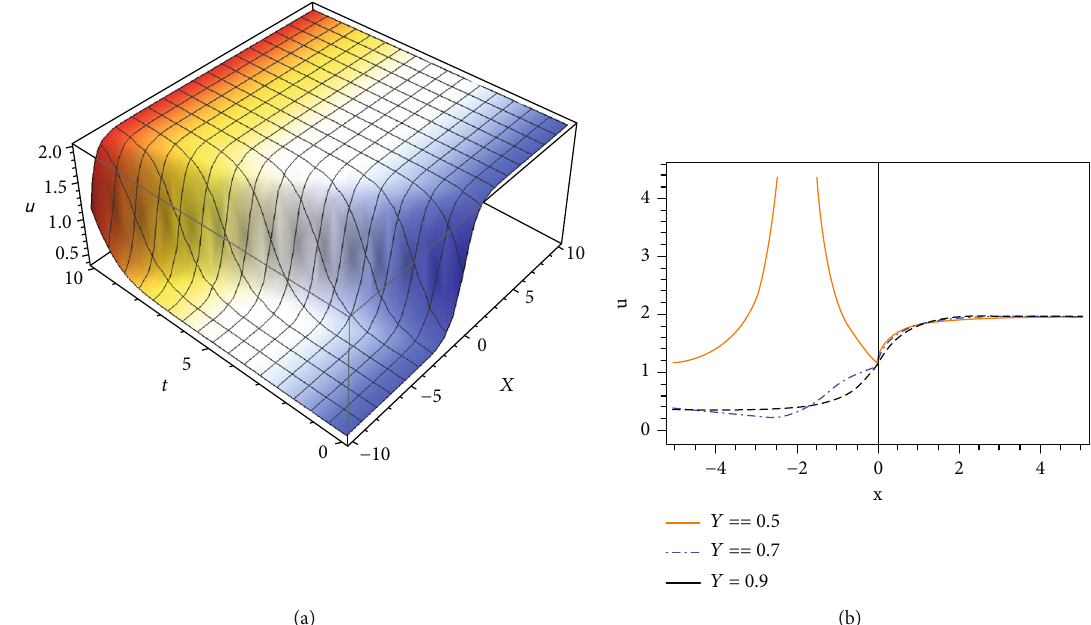
= 1 , T = 2 , V = 1 , c = 3 , a = 1 , b = 1 , and γ = 0 : 5,0 : 7,0 : 9 for the solution j u 1